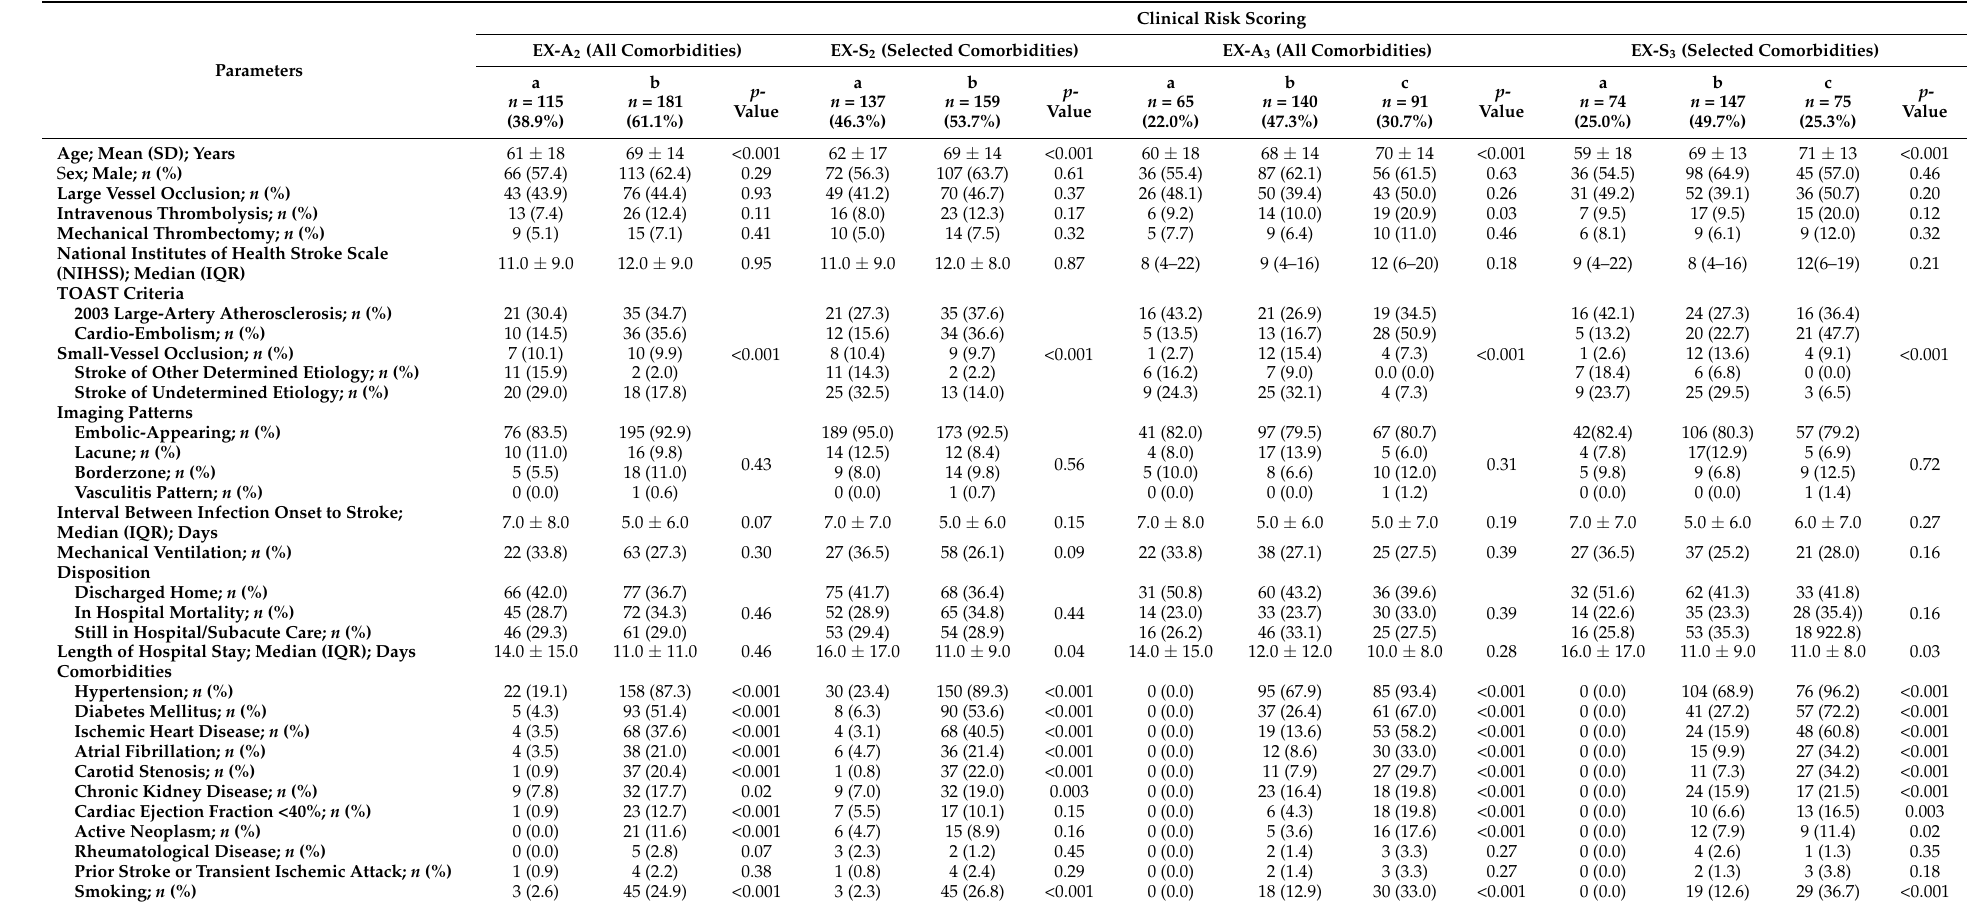
Table 1. Characteristics of the patients grouped by clinical risk scoring